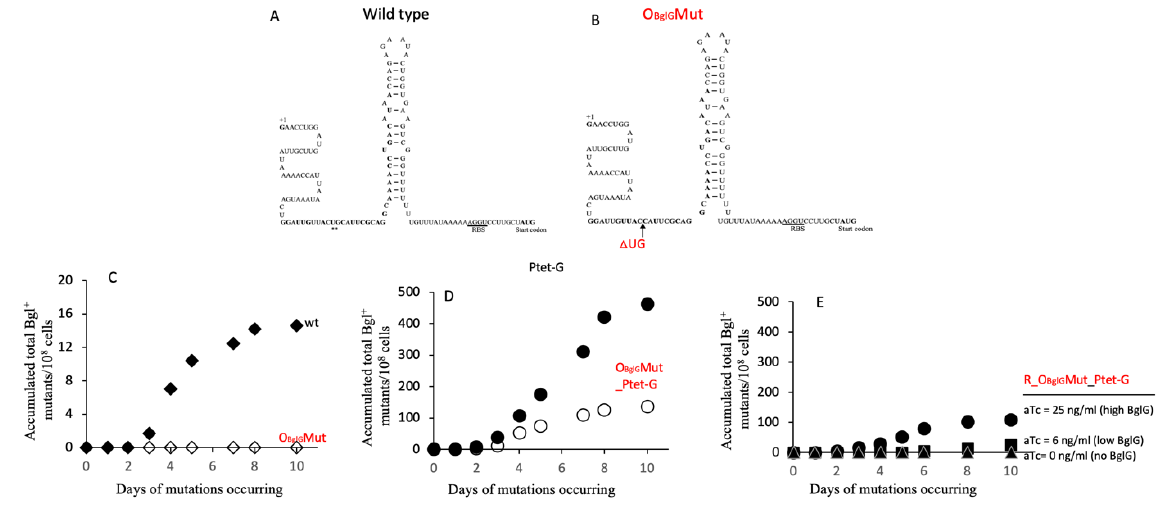
Figure 6. Effects of altering the BglG binding site on the nascent mRNA on the frequency of Bgl + mutations. ( A ) Diagram of the first terminator T1, a Rho-independent hairpin structure. The BglG binding sequences (OBglG), partially overlapping with the hairpin structure, are bolded. ( B ) Diagram of the first terminator with a 2-bp (UG) deletion in the BglG binding site on the mRNA. In both A and B, the transcriptional start site is labeled +1. The RBS is underlined, and the start codon, ATG, of bglG is bolded. ( C ) Effect of deleting the “UG” bases in OBglG (referred to as strain “OBglGMut”) on Bgl + mutation frequencies in wild type cells. ( D ) Effect of deleting the “UG” bases in OBglG on Bgl + mutations in Ptet-G cells (that is, strain OBglGMut_Ptet-G). ( E ) Effects of various BglG levels on Bgl + mutation frequencies in OBglGMut cells (that is, strain R_ OBglGMut_Ptet-G) with an altered BglG binding site in the DNA and the nascent mRNA.